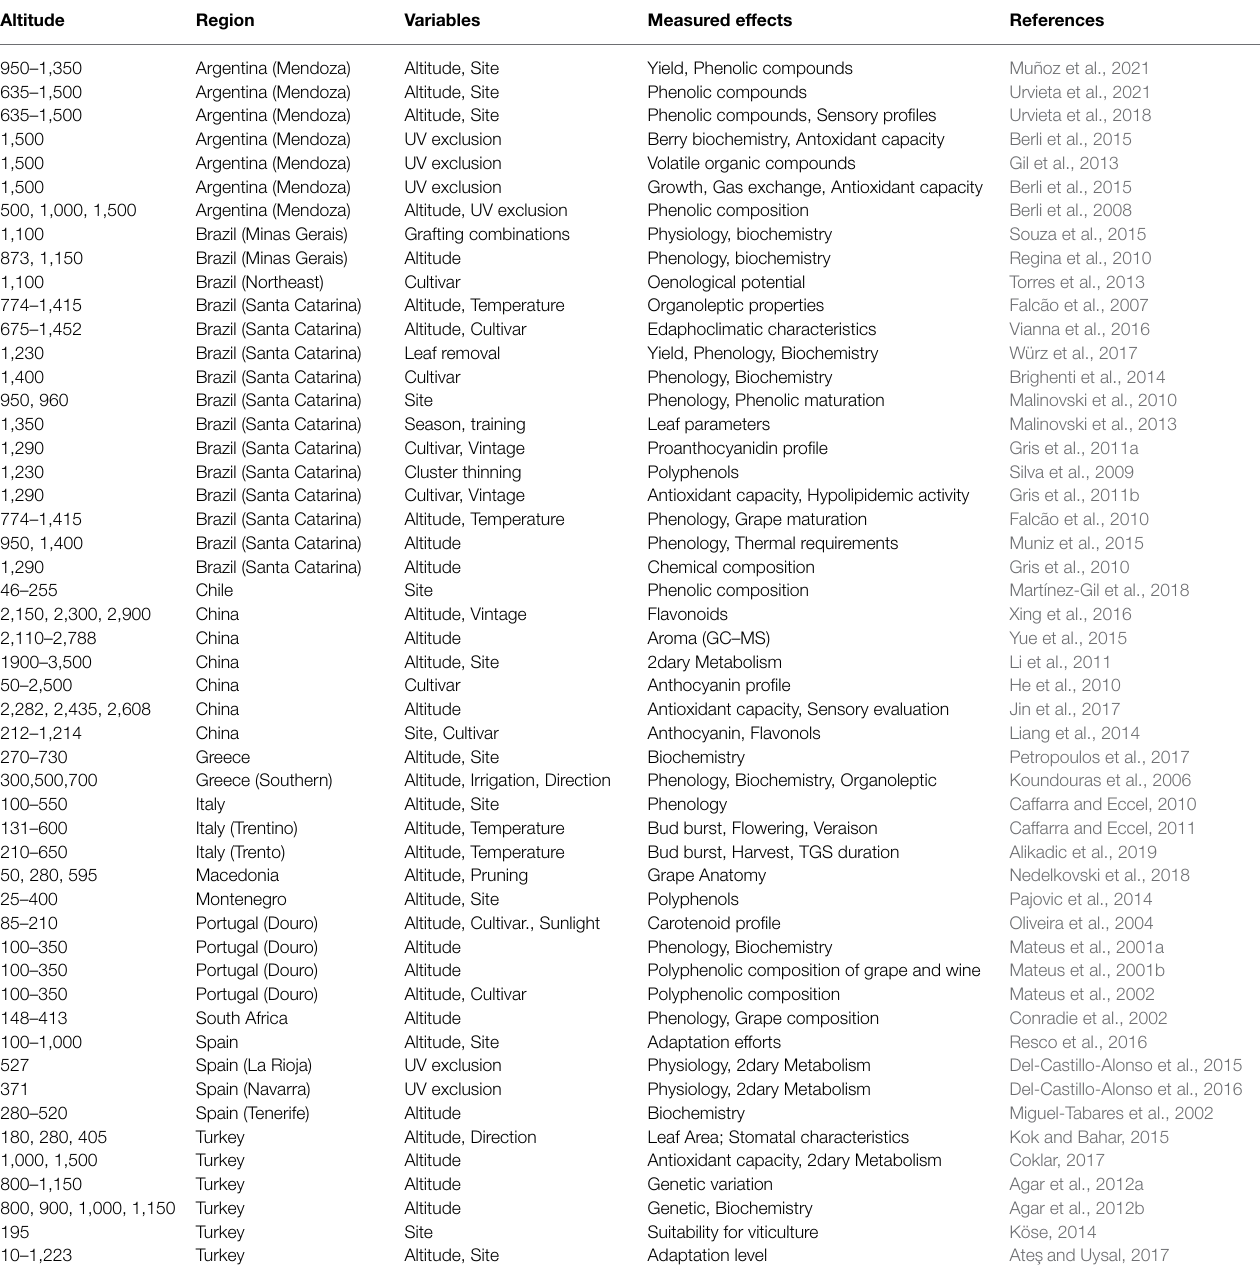
TABLE 1 | Research papers studying different magnitudes of high altitude and their effect in grapevine. Altitude